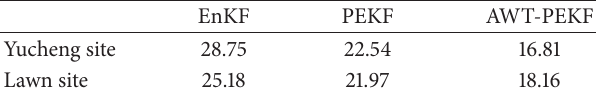
Table 2: The RMSE results of the three methods using the two site